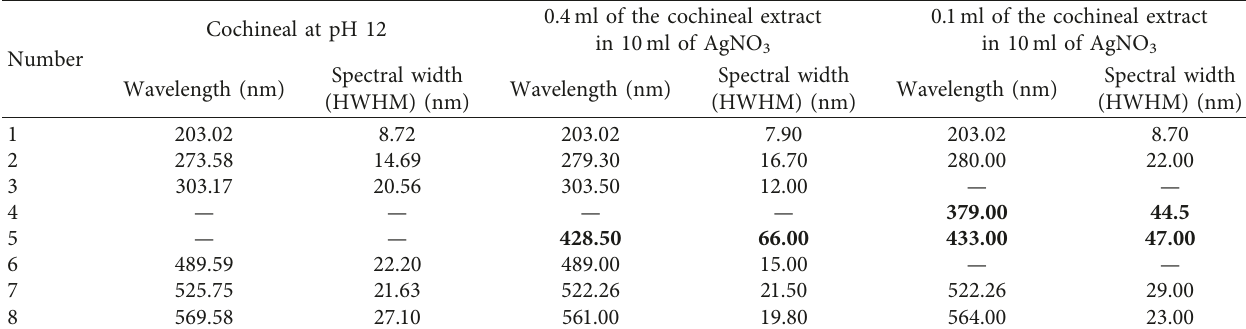
Table 1: Wavelength analysis of the half width at half maximum (HWHM) of cochineal at pH 12 and biosynthetic AgNPs at different initial volumes (0.1 and 0.4 ml) of the cochineal extract.